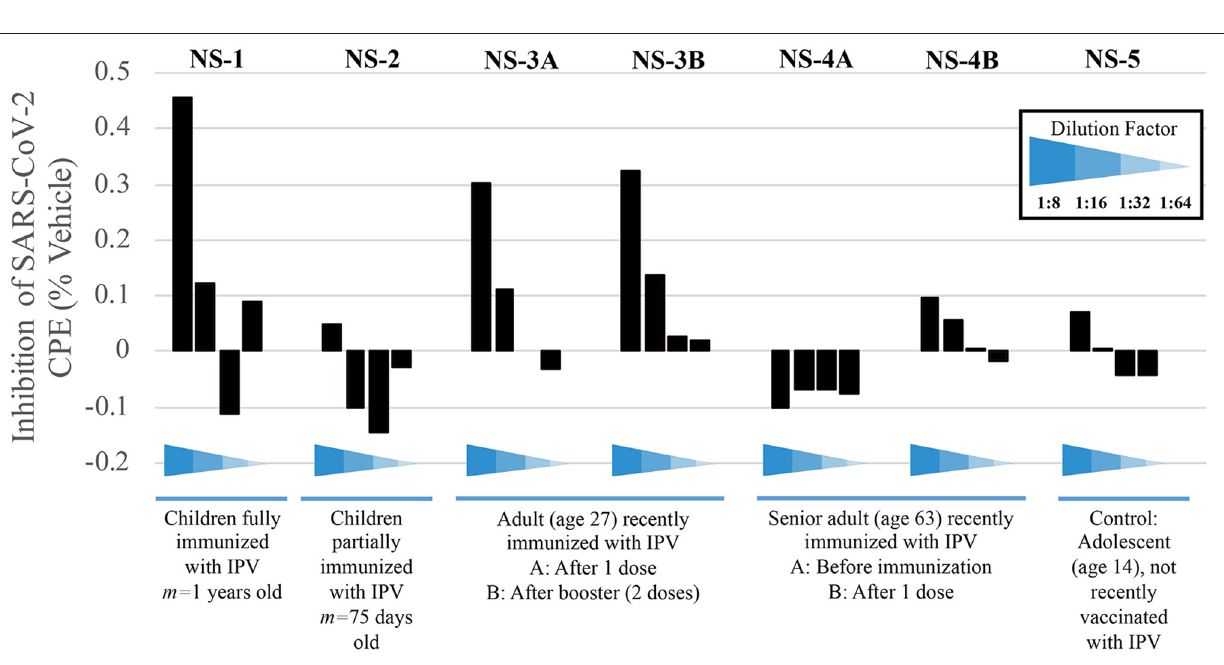
FIGURE 5 | Sera from immunized individuals demonstrate higher inhibition of SARS-CoV-2-induced CPE. Sera from five test subjects of varying ages and IPV-immunization stages were added before viral adsorption. Values show the inhibition of the SARS-CoV-2-induced CPE, as a surrogate marker for the inhibition of viral replication; inhibition percentage was calculated by average O.D. 540nm from each well, normalized with mock and vehicle control from the same plate (see